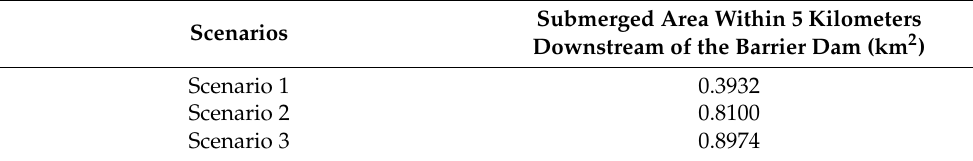
Figure 12. Flooding range map for scenarios 1, 2, and 3. Table 7. Submerged area of scenarios 1, 2, and